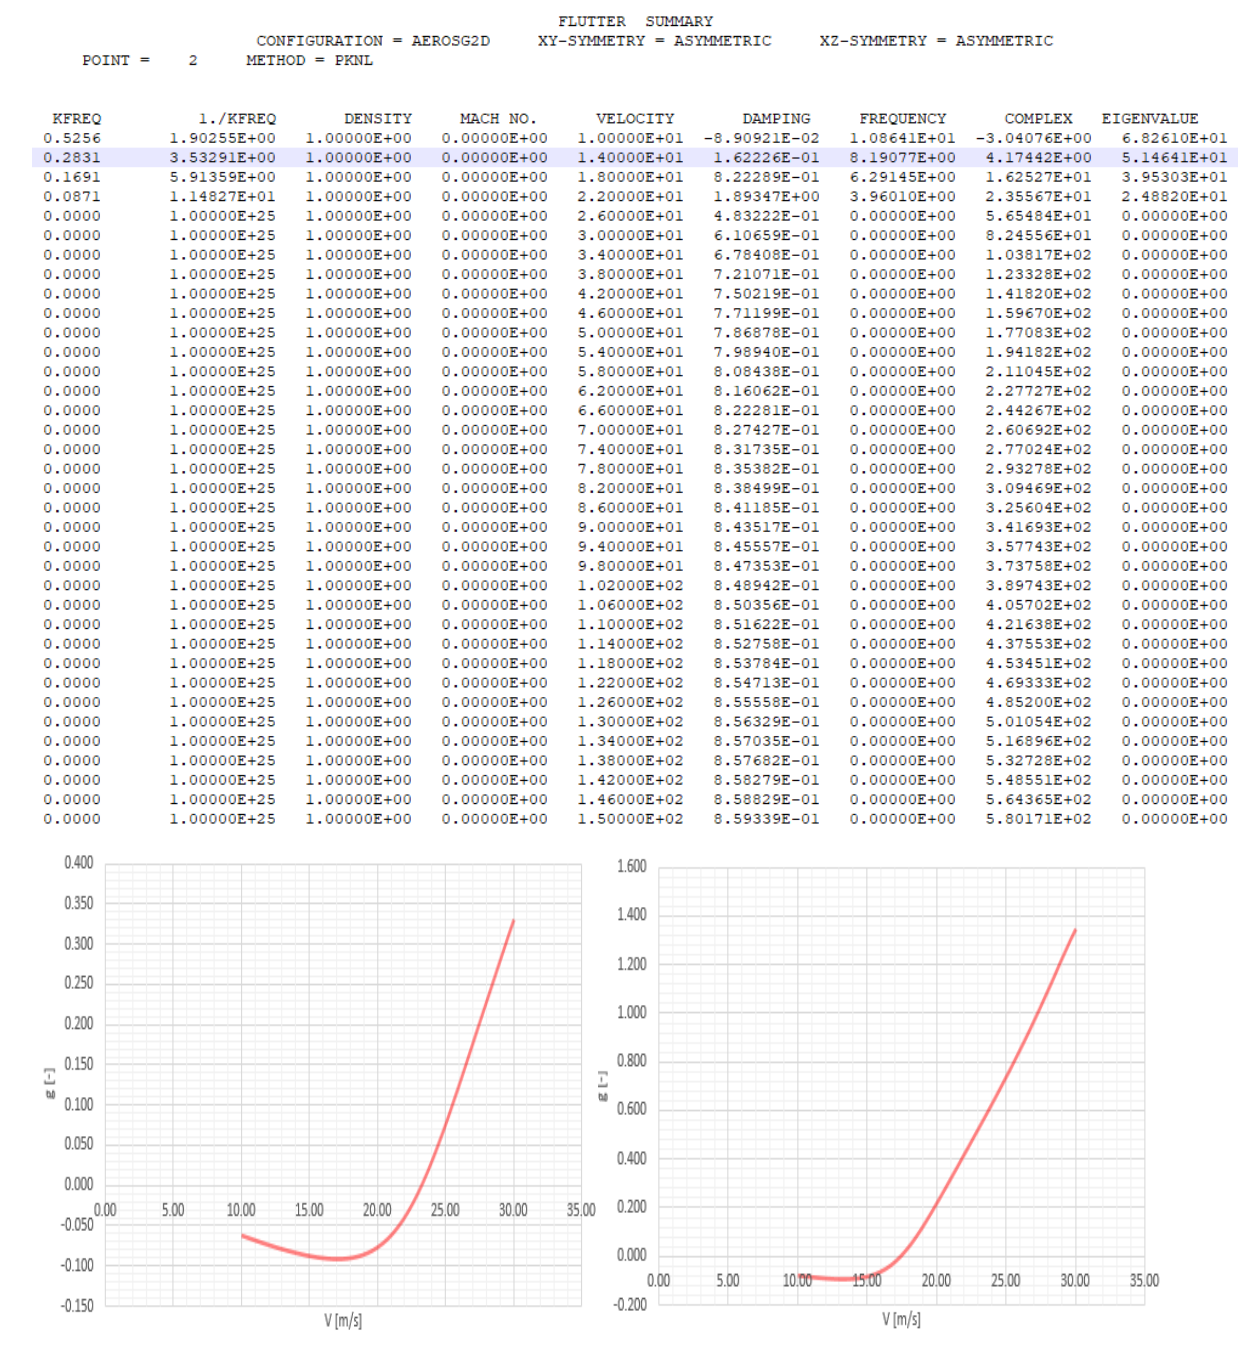
Table 7 CFA Results For AR=1 and λ =0.7